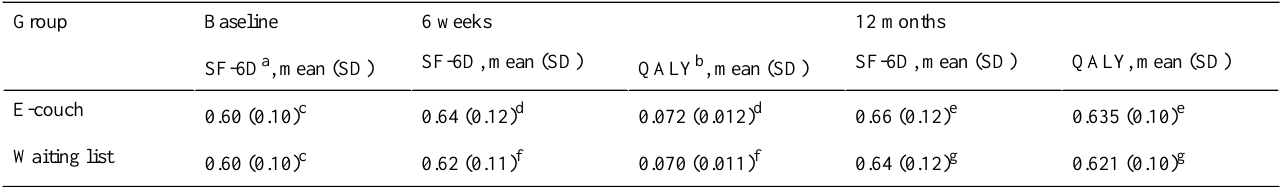
Table 5. Health status and quality-adjusted life years at baseline, 6 weeks and 12